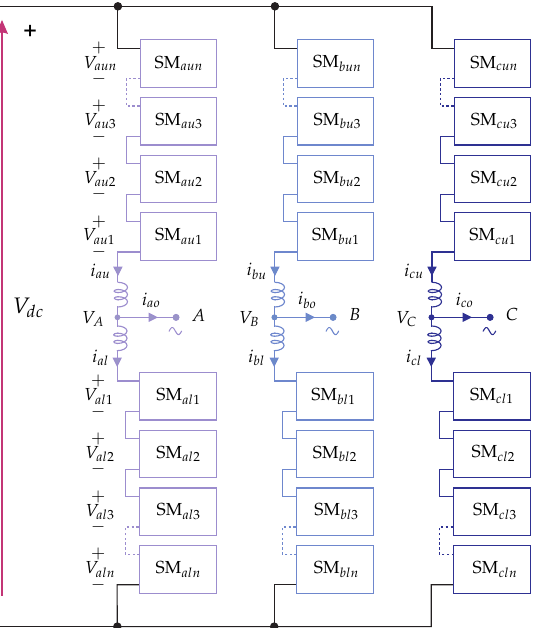
Figure 1. Three-phase equivalent circuit and main parts of MMC